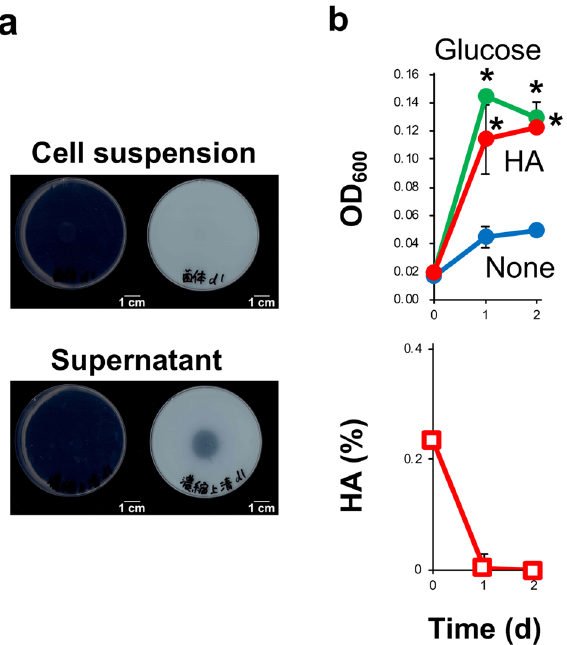
Figure 6. Isolation of HA-utilizing bacteria from human oral microbiota. ( a ) HA degradation by G. adiacens . Cell suspension or supernatant was spotted on the center of the halo-forming plate for 1 day (left). Acetic acid was spread onto the plate for halo formation (right). ( b ) Assimilation assay of HA by G. adiacens . Growth of G. adiacens in nutrient-poor medium (1/20 × GAM; blue) or the same liquid medium but containing glucose (green) or HA (red) as a carbon source was compared (top). * p < 0.05, significant growth promotion compared to growth in nutrient-poor medium (1/20 × GAM; t test). HA concentrations during growth in HA-containing